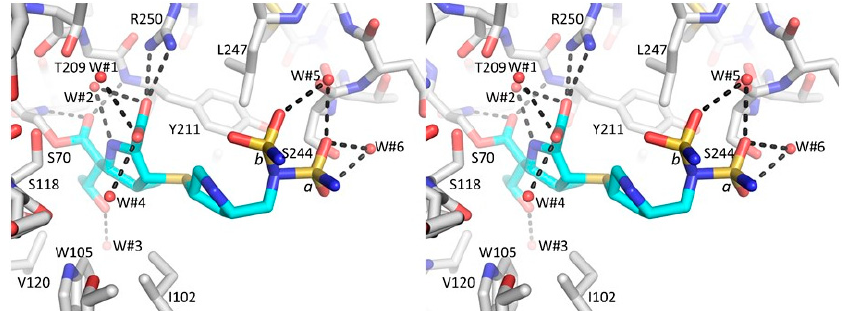
Figure 3. Stereo diagram of doripenem interactions in the active site of OXA-48 K73A molecule A. Hydrogen bonds are depicted as dashed black lines. Interacting water molecules are shown as red